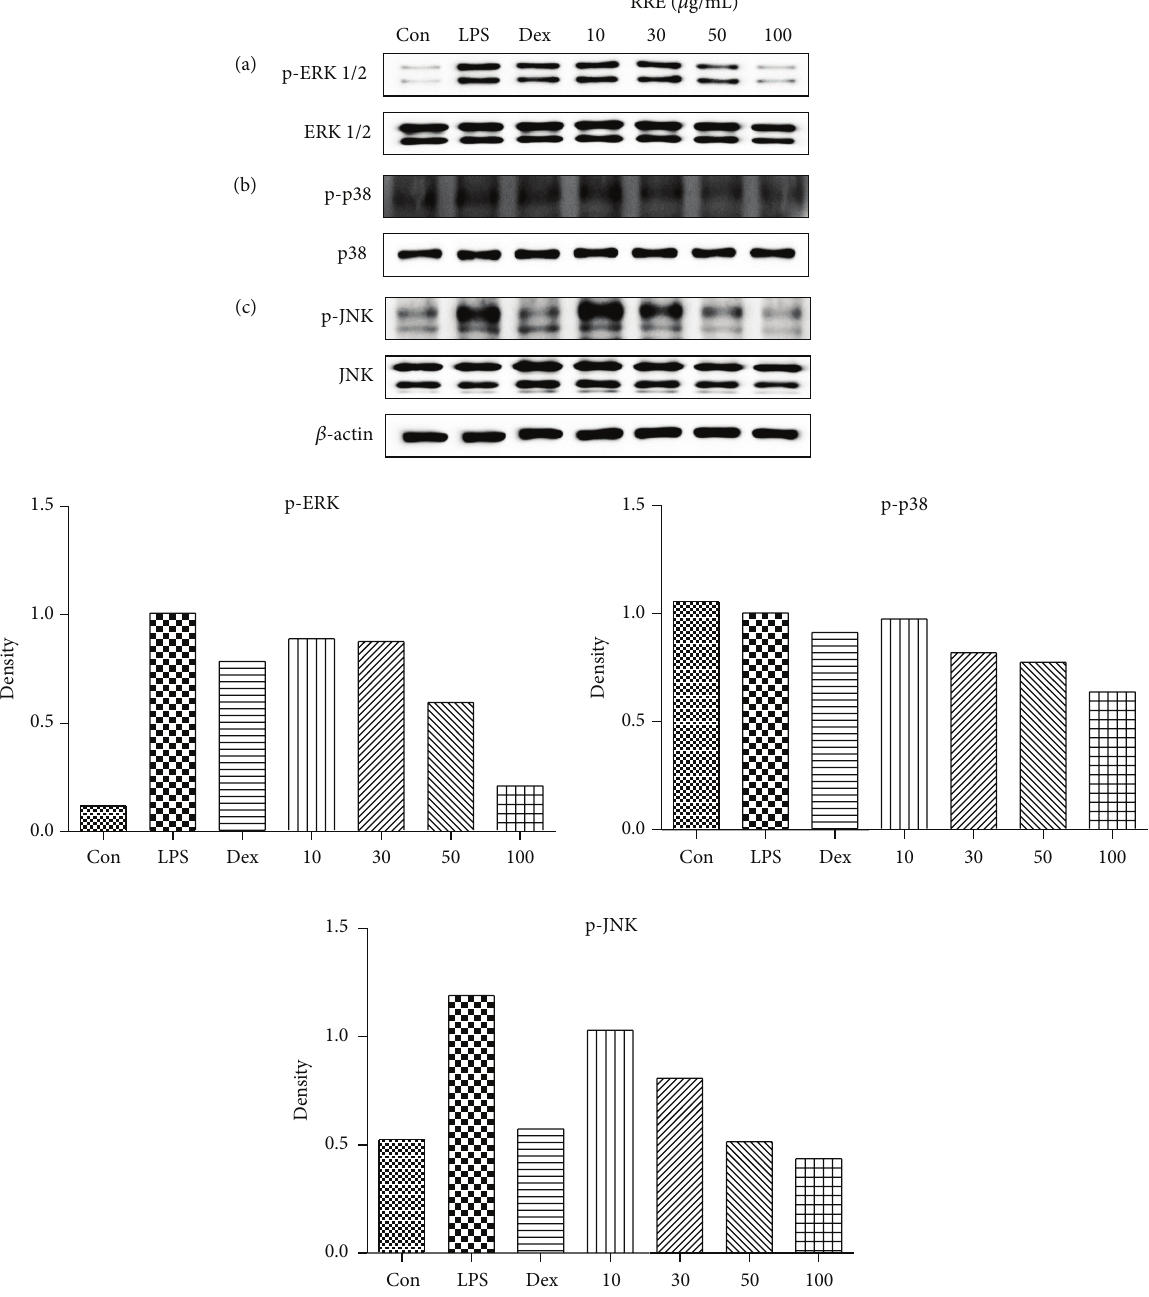
Figure 5: Effects of RRE treatment on the phosphorylation of (a) ERK, (b) p38, and (c) JNK MAPKs in RAW 264.7 cells. Cells were treated with RRE for 1h and challenged with LPS for 30min. ERK, p38, and JNK, as well as their phosphorylated forms (p-ERK, p-p38, and p-JNK), were examined by Western blot. Results are representative of three independent